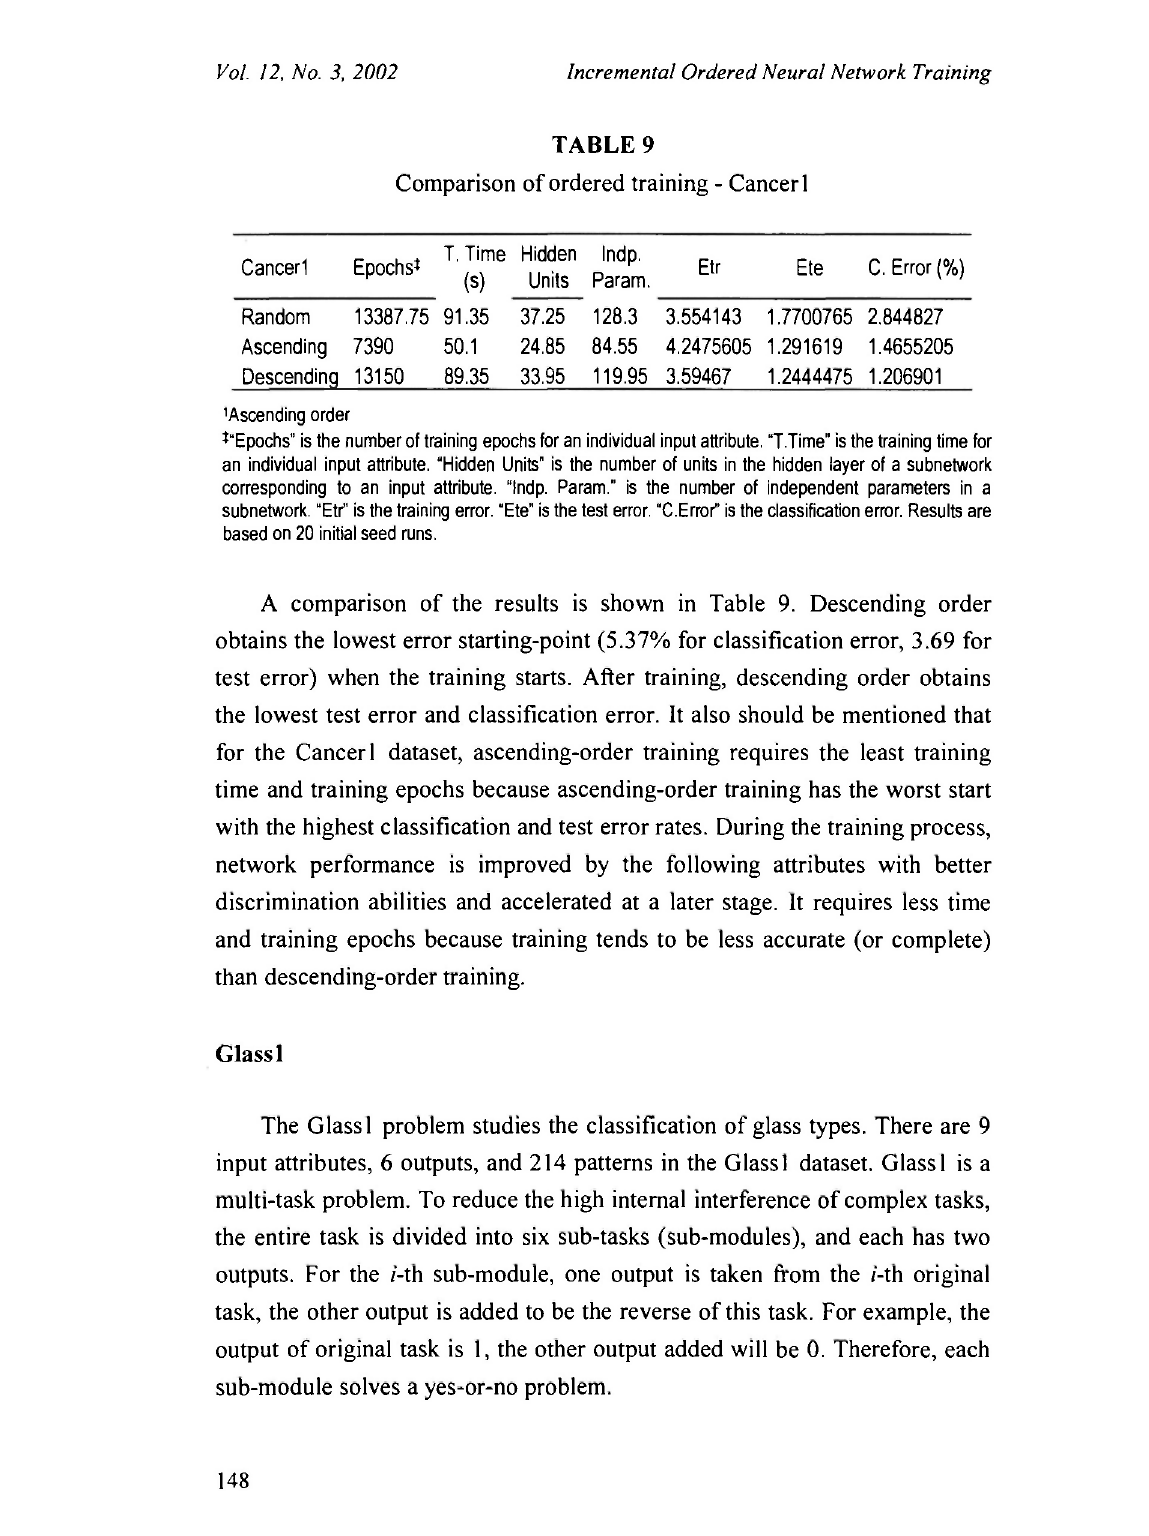
Comparison of ordered training - Cancer